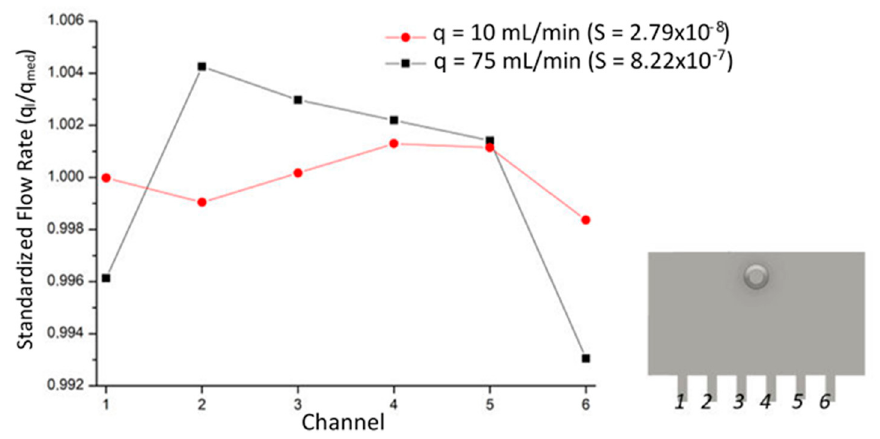
Figure 5. Flow distribution in the microchannels for two different flow rates.